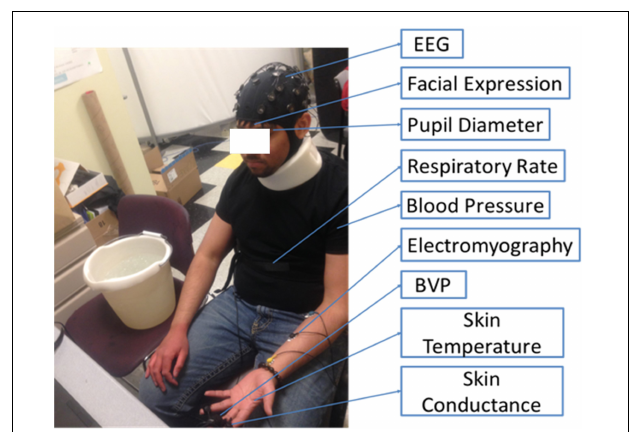
FIGURE 1 | The experimental set up of the present pain assessment study at the Intelligent Human-Machine Systems Lab at Northeastern University. The locations of nine sensors attached to a participant are